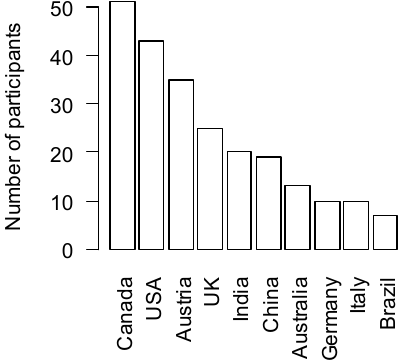
Figure 1. Distribution of players of the Cropland Capture game among the top 10 countries with the most participants. Only participants who rated at least 1000 images are included in this figure. An additional 105 players from 53 other countries were included in the analyses in this paper.